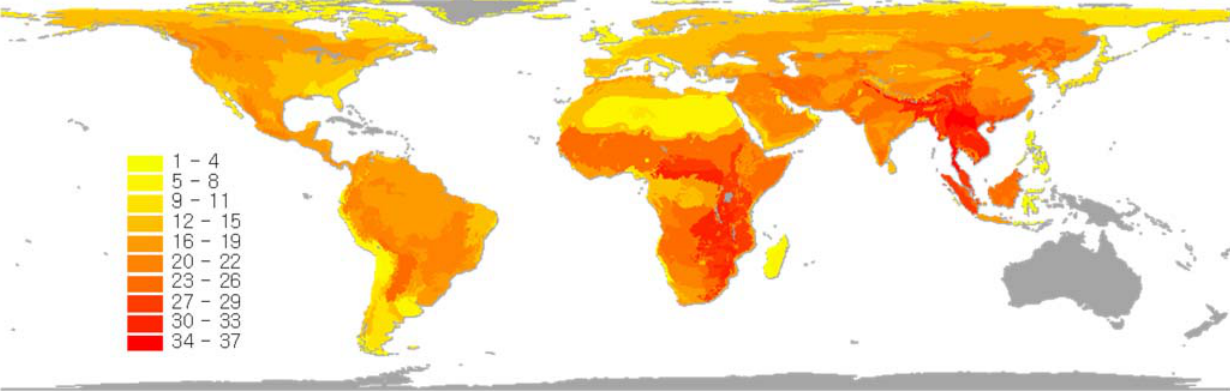
Figure 1. Global pattern of carnivore species richness.